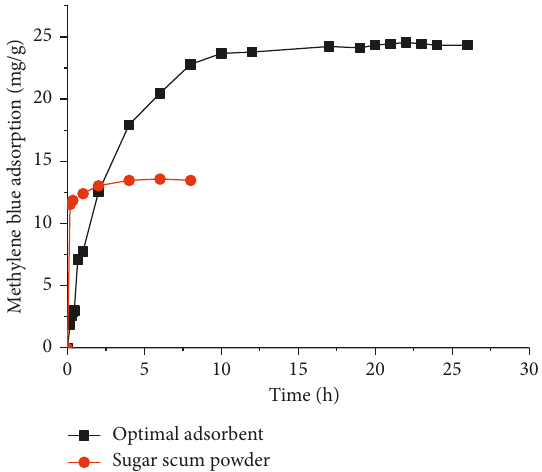
Figure 6: Effect of initial methylene blue concentration on the adsorption capacity of optimal adsorbent and sugar scum